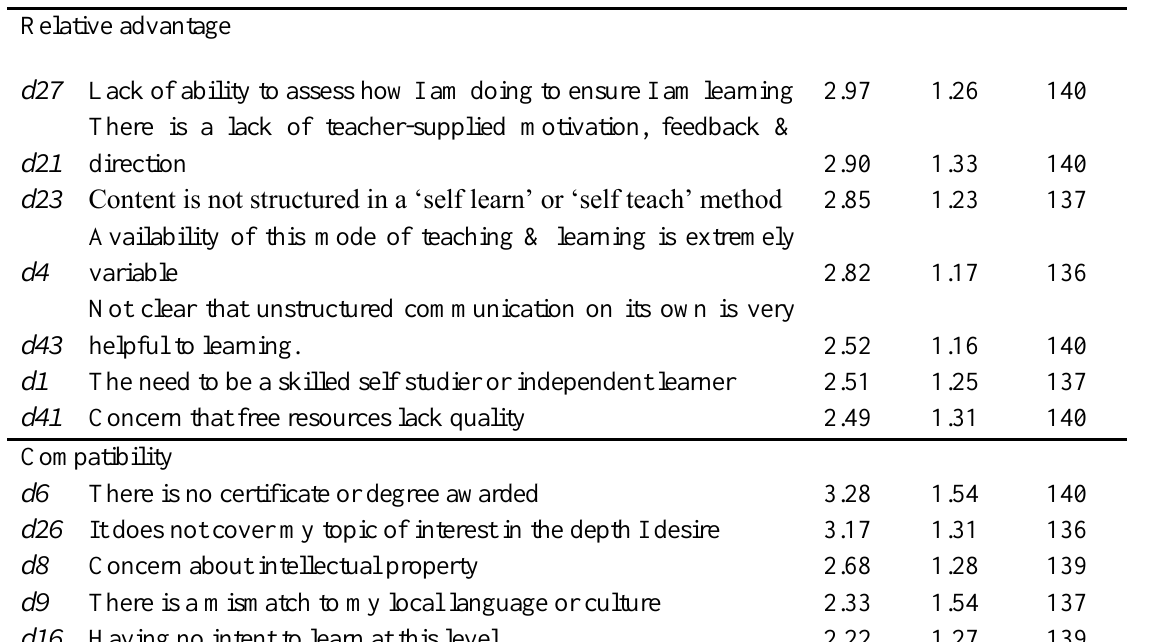
Table 2 Descriptive Statistics of Responses for Disincentives by Rogers’s Attributes (N = 140)